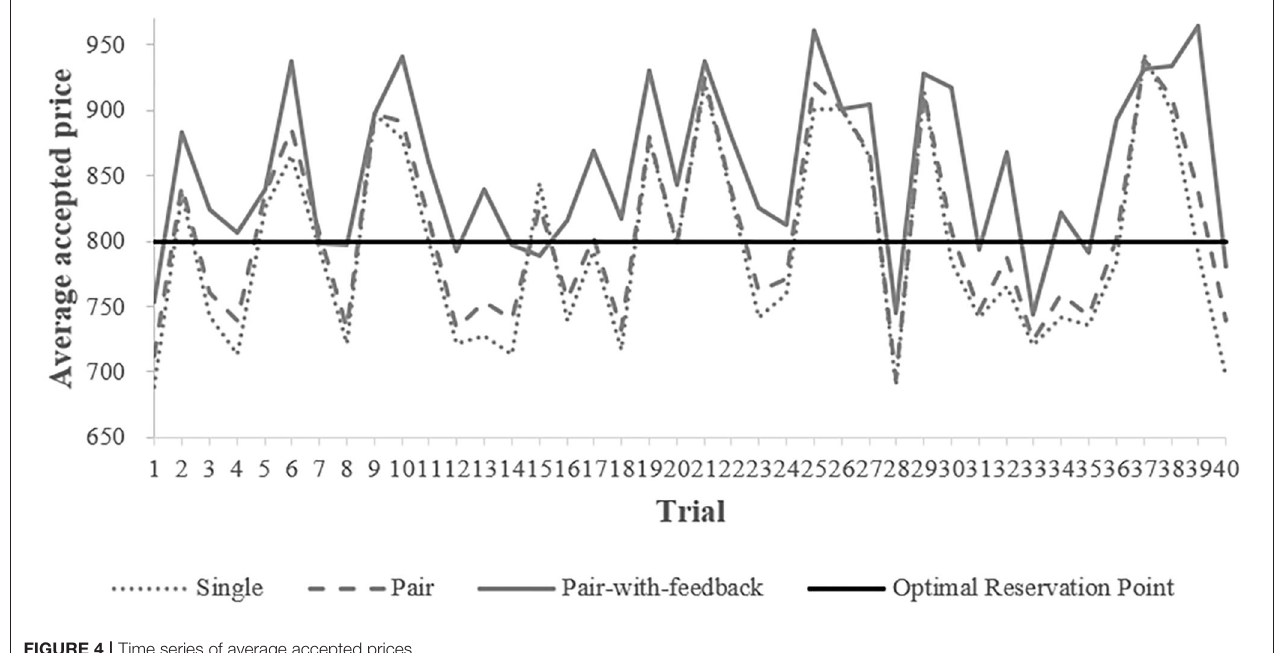
FIGURE 4 | Time series of average accepted prices.